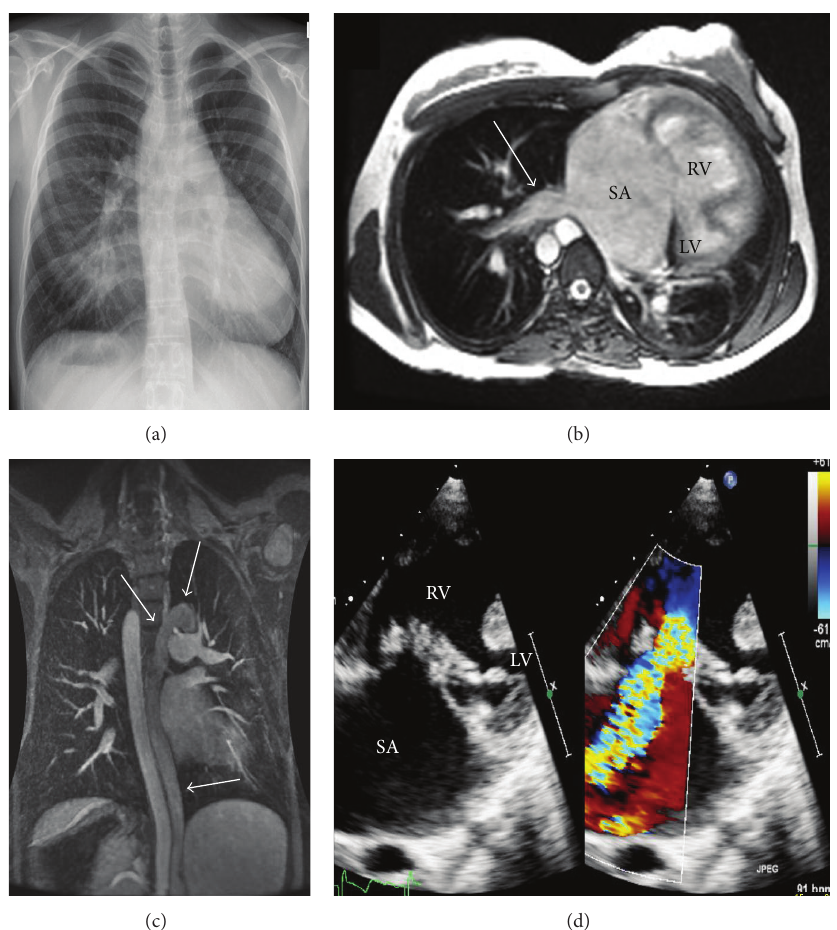
Figure 3: 24 year old patient with heart failure and complex cardiac anatomy in the setting of left atrial isomerism. (a): Chest X-ray. (b): Axial slice of cardiac magnetic resonance imaging, showing a single atrium (SA) with direct connection of hepatic veins (arrow), dominant right ventricle (RV) and hypoplastic left ventricle (LV). (c): Coronal slice of cardiac magnetic resonance imaging showing hemiazygous continuationtoleftsuperiorcavalvein(arrows)intheabsenceofarightsuperiorcavalvein.(d):Apicalechocardiographicviewdemonstrating the dominant right ventricle (RV), the hypoplastic left ventricle (LV), the enlarged single atrium (SA) and the dysplastic tricuspid valve. On the right hand of the panel color Doppler demonstrates severe tricuspid